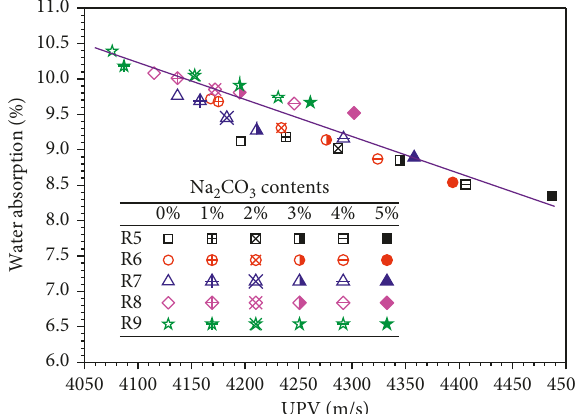
Figure 6: Relationship between water absorption and UPV for all samples containing Na 2 CO 3 .